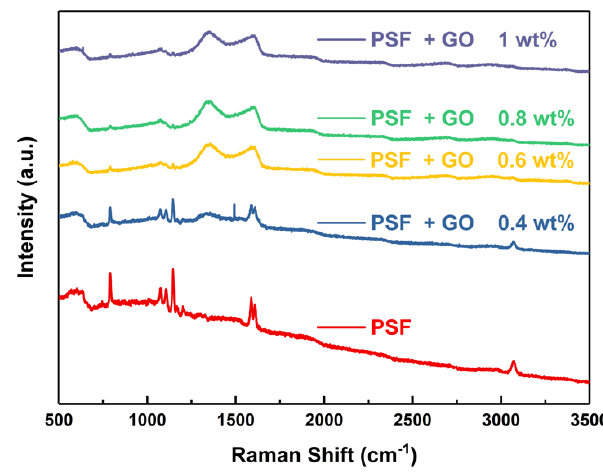
Figure 4. Raman spectra of PSF and PSF/GO membranes.